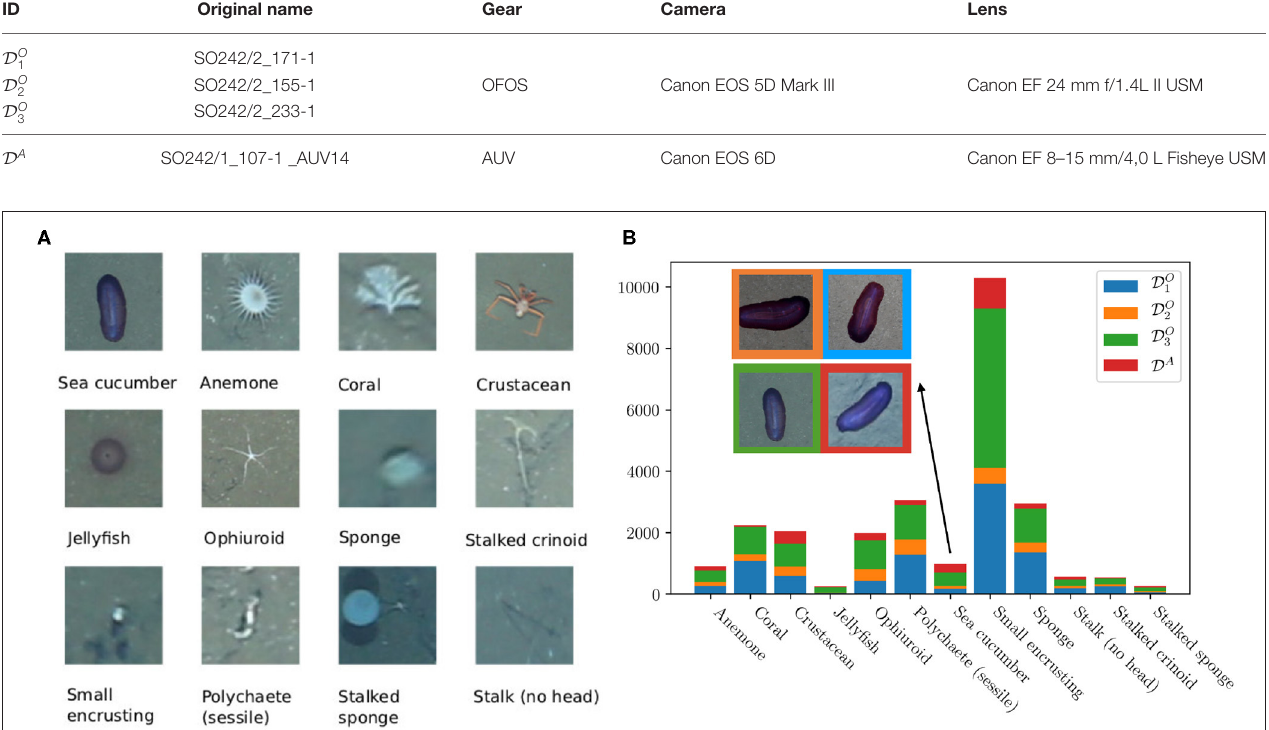
FIGURE 1 | From all 23 detected classes, the 12 most abundant classes of morphotypes were selected for this study. One example of each class from data set D O 3 is shown in (A) . In (B) the abundance of each class in each data set is illustrated. In the upper left of the plot, one example of the morphotype “Sea cucumber” from each data set is shown for comparison.